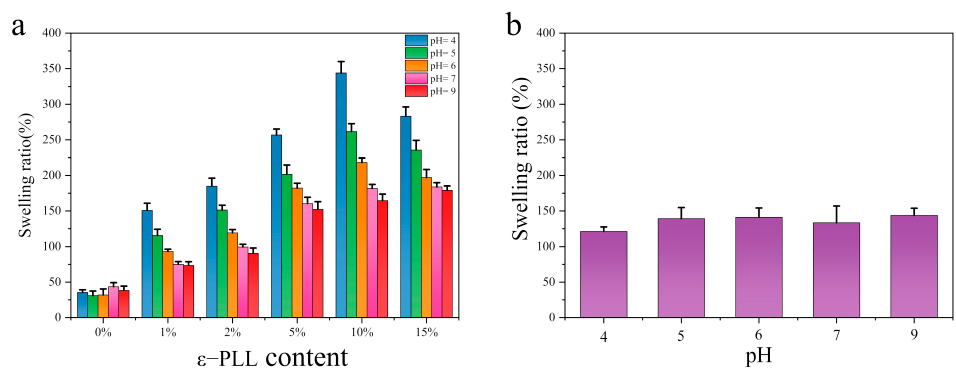
Figure 8. Swelling ratio of hydrogel at different pH: ( a ) CSF hydrogel (The solid content of SF and CSF solution is 3 wt.%, HRP concentration is 10 U/mL, H 2 O 2 concentration is 1 mM); ( b ) SF/ ε -PLL hydrogel ( ε -PLL content: 10 wt.%). n = 3.